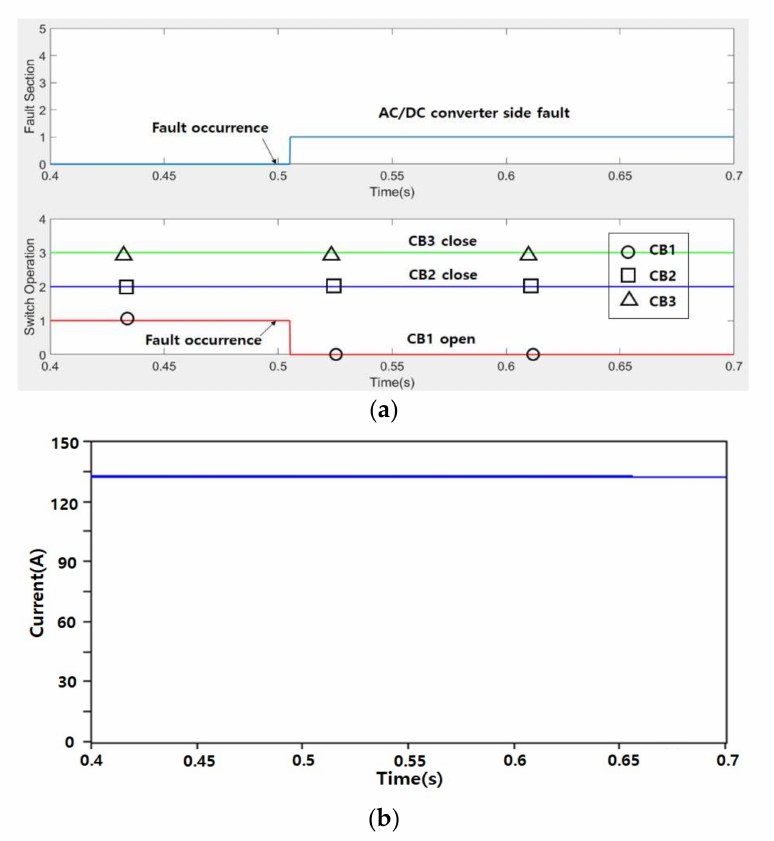
Figure 21. Simulation results of Case 7: ( a ) Fault section and CB operation and ( b ) Load